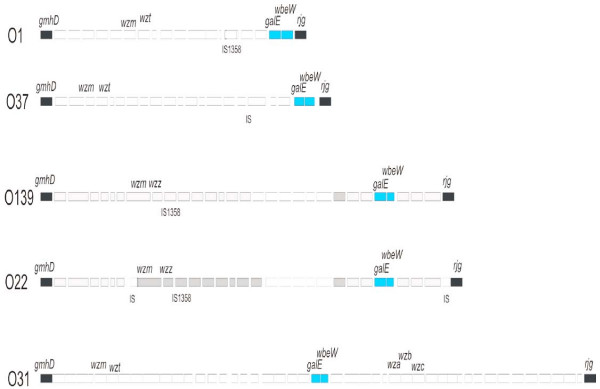
Pictorial representation of the genes in the LPS/CPS regions of O1, O37, O22, O139 and O31 Vibrio cholerae. The galE and wbeW genes found in common between all five sequences are marked in blue. The housekeeping genes gmhD and rjg that delineate the region are marked in black. The genes in common between O22 aand O139 are marked in grey. The transport genes and the IS elements are labeled. The unlabeled genes represented by white boxes are not found in common across the regions.